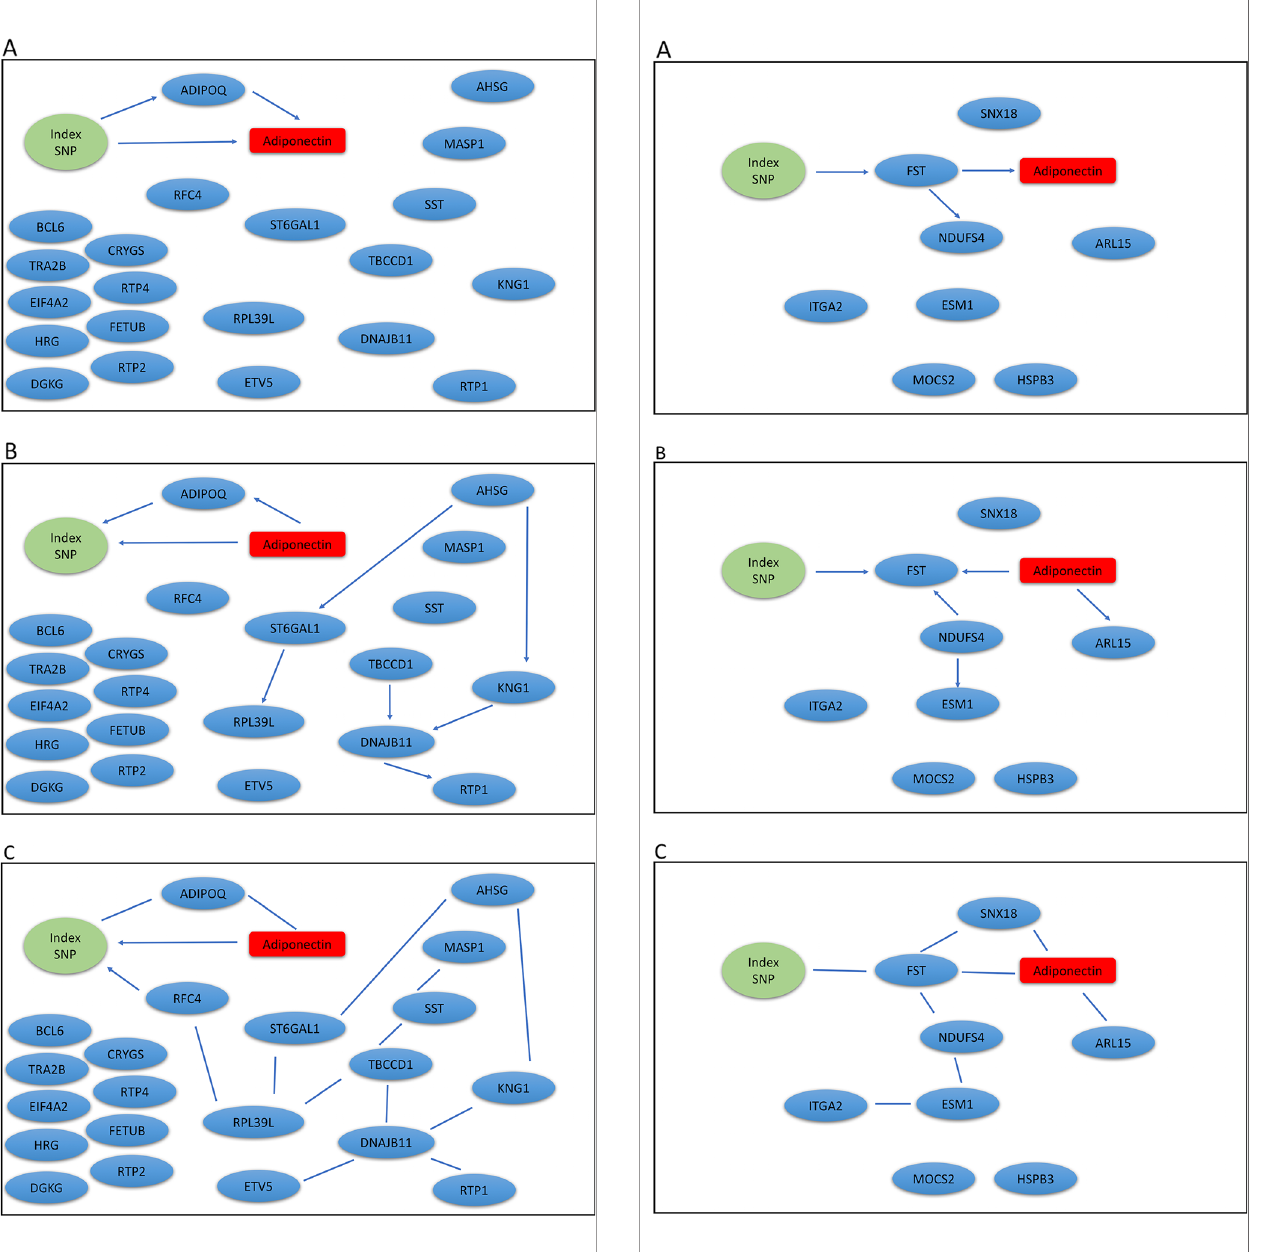
FIGURE 3 | Graphic results for causal network analysis of the Metabolic Syndrome in Men dataset, a mixed type dataset consisting of a categorical variable, genotypes of one index SNP at the ADIPOQ GWAS locus, and several continuous variables, including expression levels of 21 genes and plasma adiponectin levels (disease trait). The arrows indicate direction of causality. (A) mDAG; (B) MMHC; (C) CPC-stable.